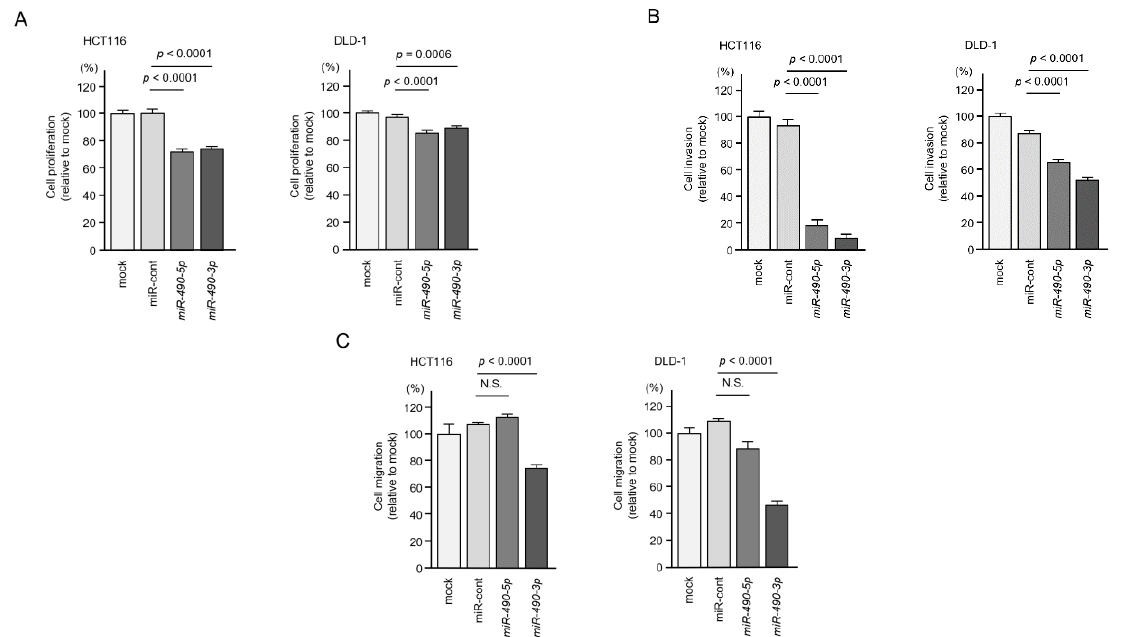
Figure 4. Tumor-suppressive roles of miR-490-5p and miR-490-3p in colorectal cancer (CRC) cells (HCT116 and DLD-1). Functional assays of miR-490-5p and miR-490-3p in CRC cells using miRNAs precursors. ( A ) Cell proliferation, assessed by XTT assay, 72 h after transfection of mature miRNAs ( B ) Cell invasion, determined by Matrigel invasion assay, 48 h after seeding inhibitor-transfected cells into the chambers. ( C ) Cell migration assessed, using a membrane culture system, 48 h after seeding inhibitor-transfected cells into the chambers.